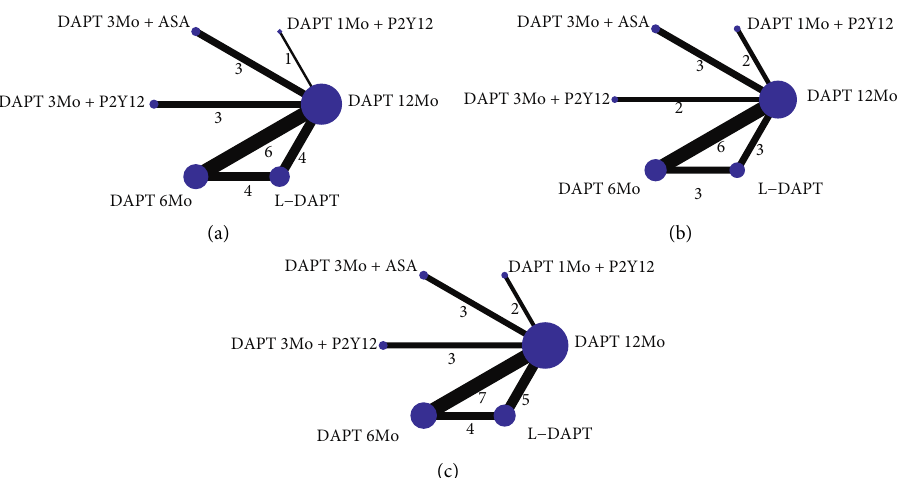
Figure 2: Network plot of treatment comparisons. Network diagram nodes represent individual interventions and nodes connected by lines indicate that these two interventions have been directly compared in a randomized trial. The nodes are weighted by the number of randomized trials evaluating this treatment and lines are weighted by the number of randomized trials evaluating this treatment com- parison. (a) Cardiac death. (b) Net adverse clinical events. (c) All-cause mortality, myocardial infarction, major bleeding, any bleeding and definite or probable stent 1Mo + P2Y12 concerning major and any bleeding when compared with L-DAPT. Besides, there were no significant differences between all DAPTstrategies in terms of all-cause mortality and NACE (Supplementary Table S12). Table S12). DAPT 6Mo (OR: 0.51, 95%: 0.30–0.80) was associated with a lower risk of any bleeding when compared with L-DAPT. Unlike the original meta-analysis, there was no significant benefit of DAPT 3Mo + ASA and DAPT